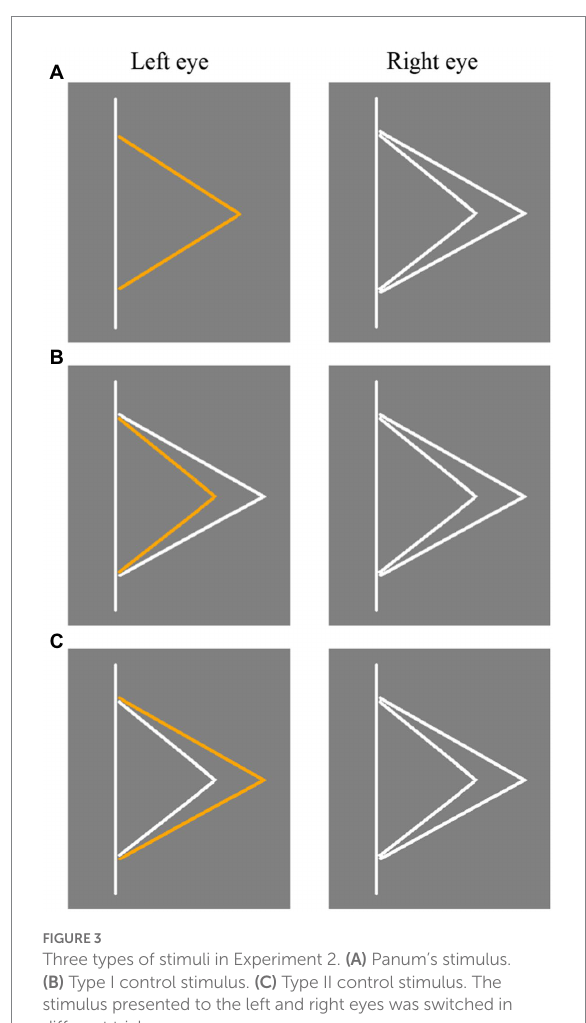
FIGURE 3 Three types of stimuli in Experiment 2. (A) Panum’s stimulus. (B) Type I control stimulus. (C) Type II control stimulus. The stimulus presented to the left and right eyes was switched in different